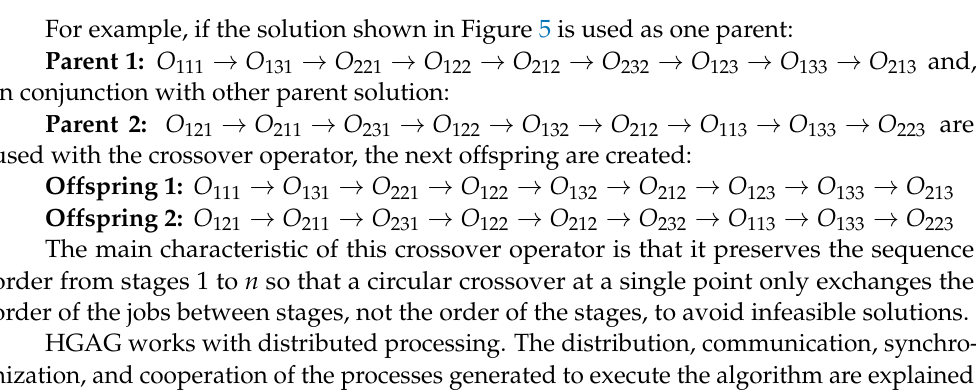
Figure 6. Roulette-based crossover operator.